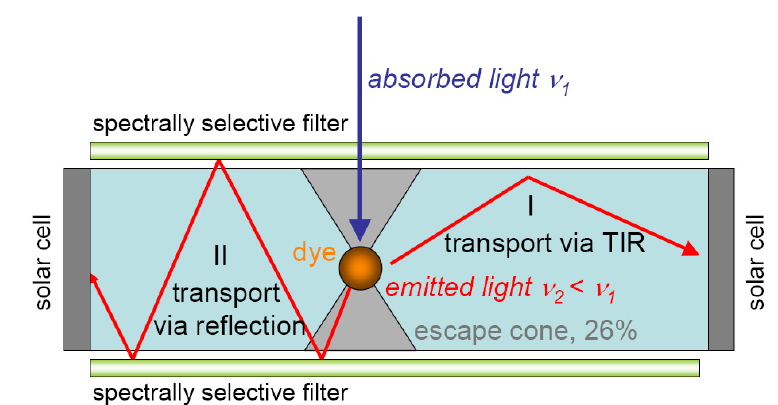
Figure 6. Concept to improve fluorescent concentrators with spectrally selective filters. In the fluorescent concentrator, a dye absorbs light and subsequently emits it with smaller frequency. The light is either emitted into a direction where total internal reflection occurs and is transported to the edges (I), or it is emitted into the escape cone and is, without filter, lost. Typically these escape cone losses cover at least 26% of the emitted light. With a filter, the filter reflects the light in the escape cone and transports it to the edges